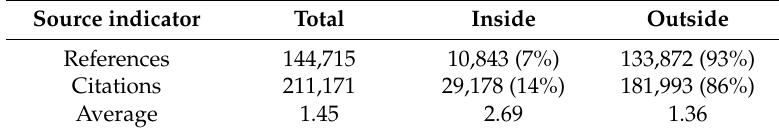
Table 7. Citations from social robotics papers to articles inside and outside robotics research.